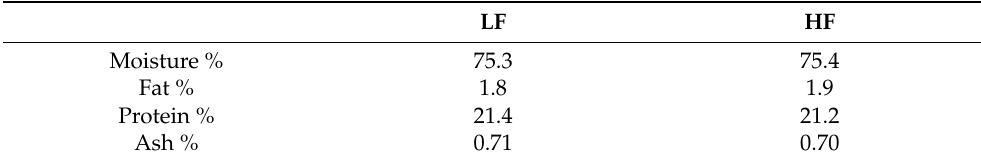
Table 4. Longissimus thoracis chemical